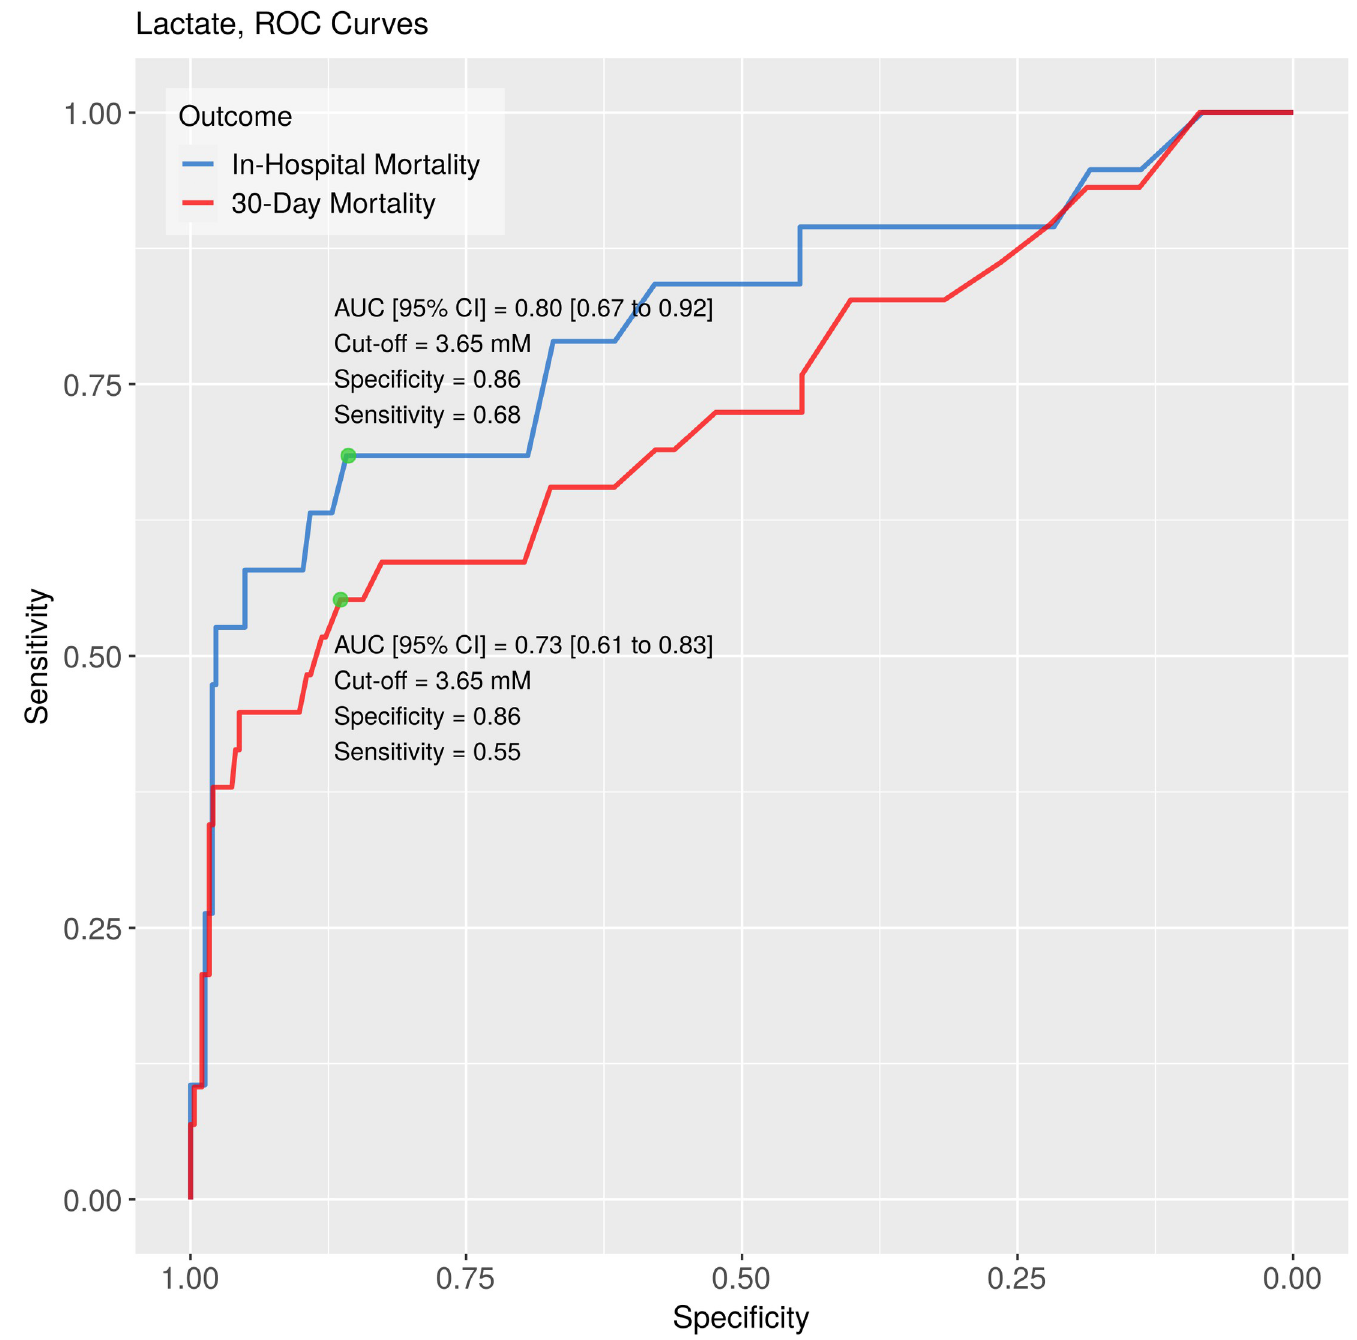
Fig 2. ROC curves for lactate as predictor. Lactate level alone may have good predictive ability for predicting both in-hospital and 30-day mortality. ROC: Receiver Operating Characteristics; AUC: area under curve. https://doi.org/10.1371/journal.pone.0277785.g002 For time- to-event analysis of the 180-day data Cox modeling was applied. Again, the likeli- hood ratio test demonstrated a statistically significant improvement (Chi-square = 5.9146, p = 0.0150). Nonetheless, with this relatively small sample size, the change in the discrimina- tion slope at 180 days was not statistically relevant: IDI [95% CI]: 0.0350 [-0.0030 to 0.1090],